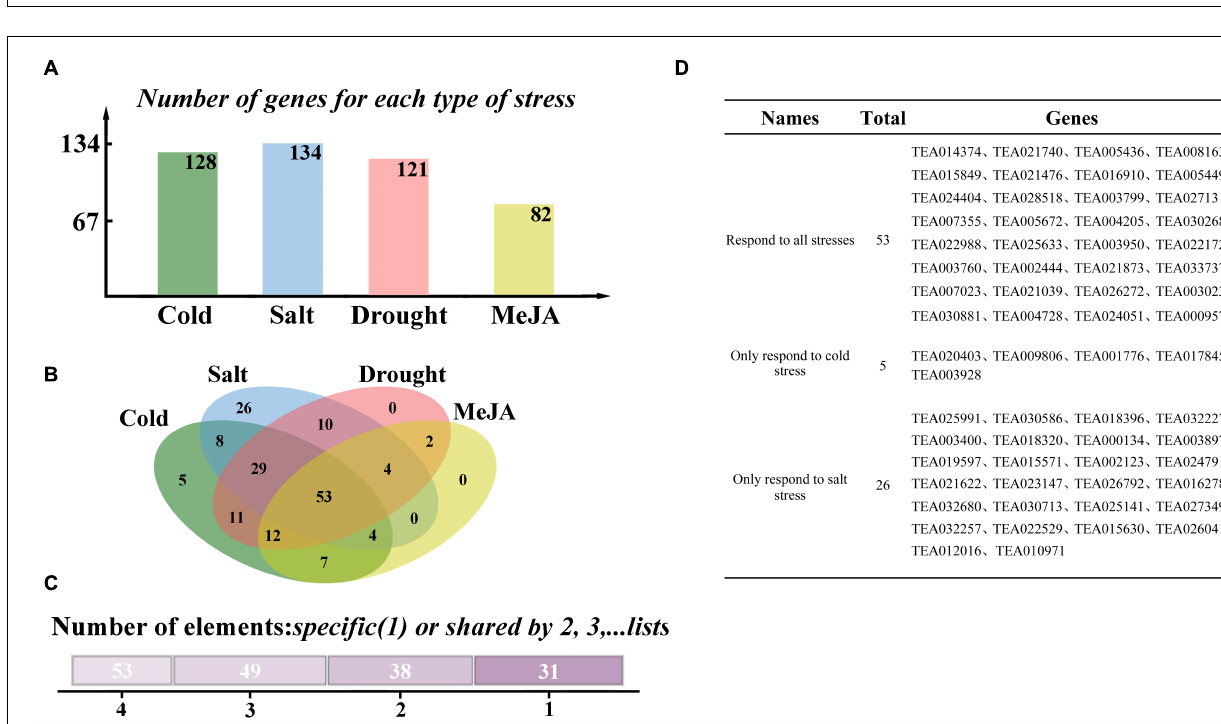
FIGURE 1 | Structural analysis of RING finger domains. Bracketed numbers represent the amount in each RING domain. *Eight conserved docking sites. Red represents amino acid conserved sites, other colors represent different residues.